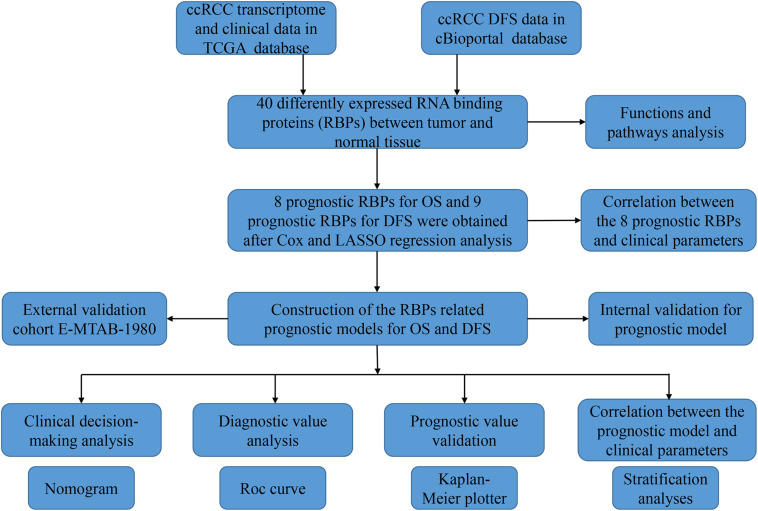
The research diagram for analyzing RBPs in ccRCC.